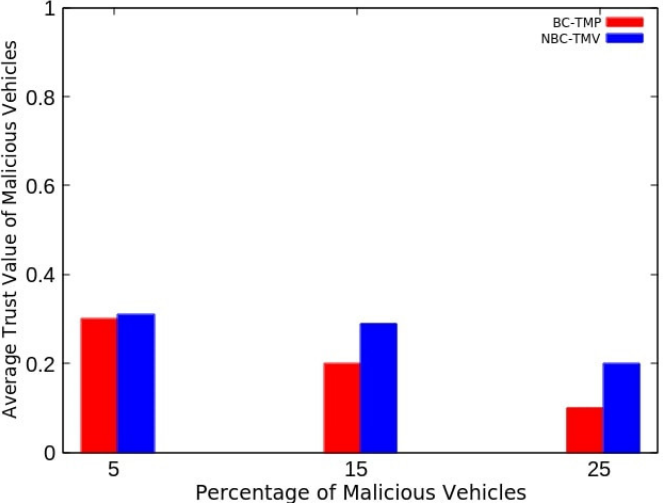
Figure 8. The average trust metric of malicious vehicles vs. the percentage of malicious vehicles in the network.